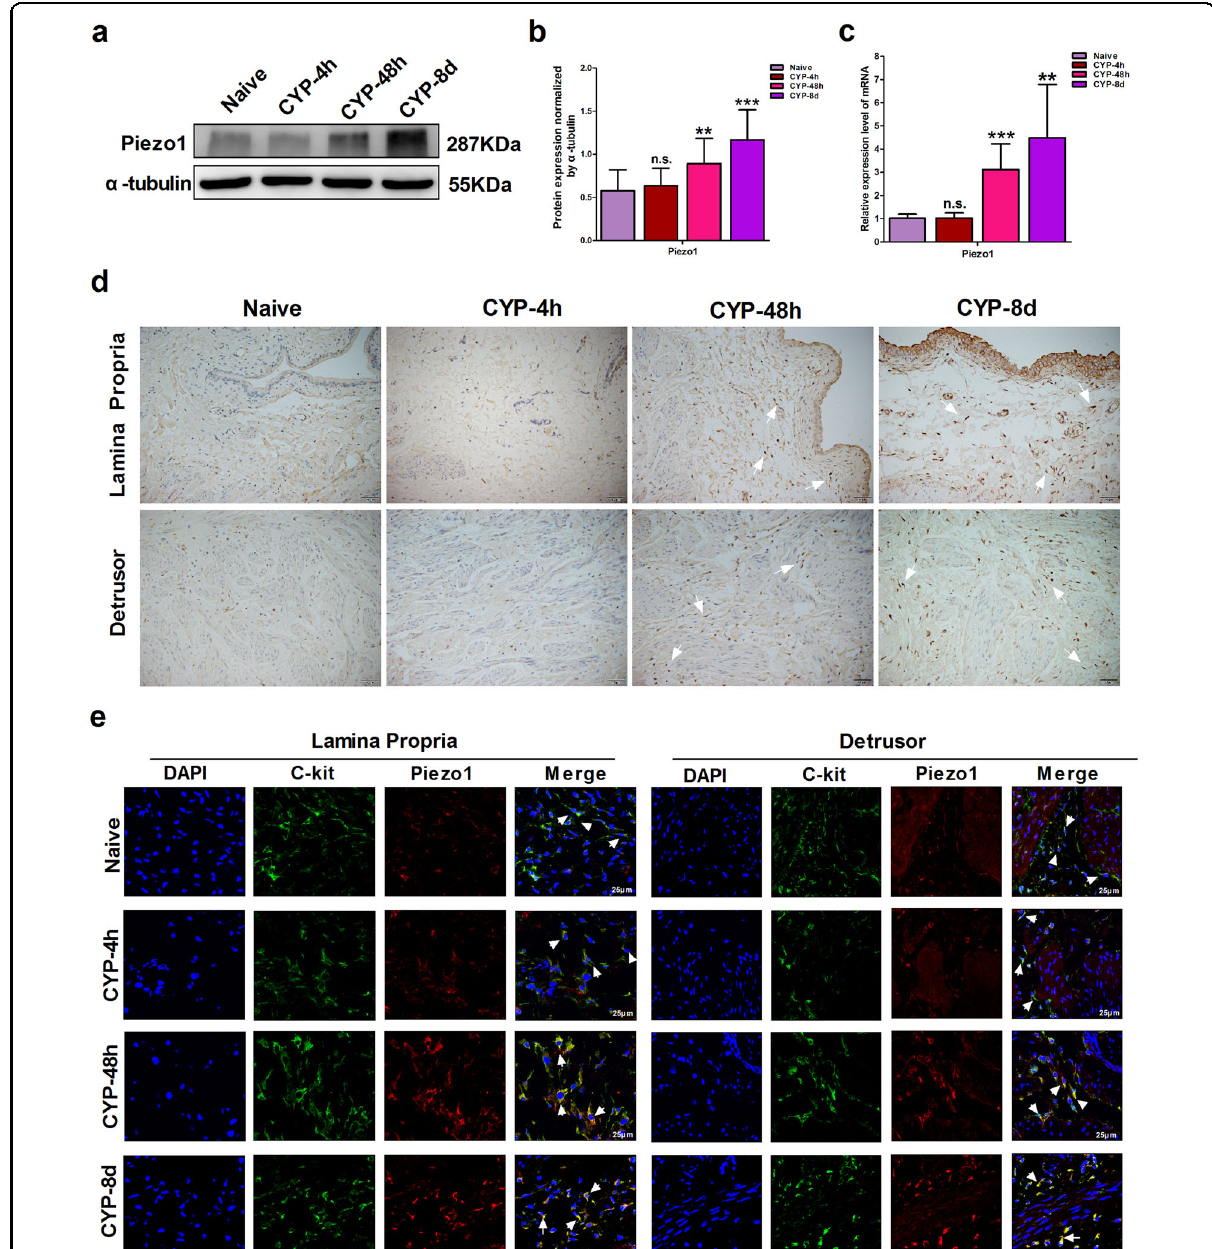
Fig. 2 Piezo1 channel expression was signi fi cantly upregulated in CYP-48h and CYP-8d rat bladders. a – c The Piezo1 channel protein and mRNA expression levels were not changed by CYP treatment for 4h but were signi fi cantly upregulated in whole bladders from CYP-48h and CYP-8d rats, and increases in CYP-8d rat bladders were more remarkable (the data represent the mean ± S.D., n = 3; ** P < 0.01, *** P < 0.001, and n.s., no signi fi cance, versus naive rats). d The IHC staining results showed that Piezo1 channel expression in bladder sections from CYP-48h and CYP-8d rats was signi fi cantly increased compared with that in bladder sections from control and CYP-4h rats, and the alterations in CYP-8d rats were more prominent. The increases in Piezo1 channel expression were principally present in the urothelium layer, as well as in the cells located in the lamina propria and intermuscular region (white arrows), but not in detrusor smooth muscle cells. e Double immunostaining of rat bladder sections showed that the Piezo1 channel (red) was expressed in c-kit (green)-positive ICC-LCs (white arrows). Compared with that in control and CYP-4h rat bladders, Piezo1 channel expression was signi fi cantly enhanced in both the lamina propria ICC-LCs and detrusor ICC-LCs in CYP-48h and CYP-8d rat bladders. Similarly, bladder ICC-LCs in CYP-8d rats possessed more remarkable increases in Piezo1 channel